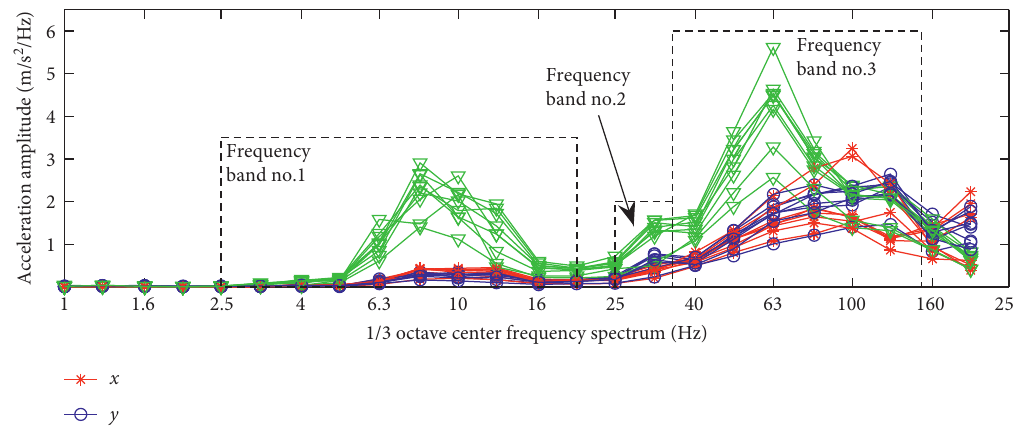
Figure 8: One-third-octave center-frequency spectrum induced by different directions ( P 4).